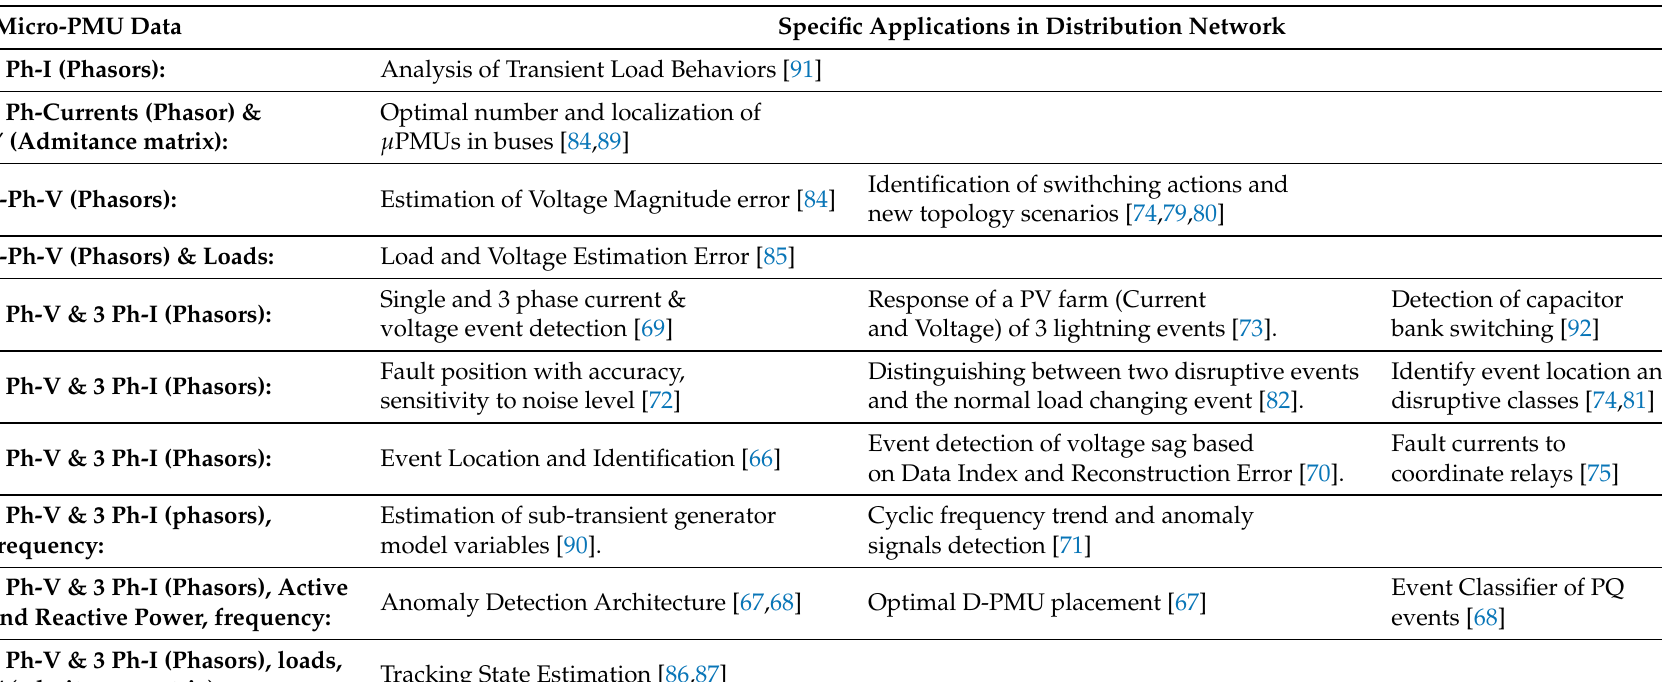
Table 3. Specific applications of Micro-PMU